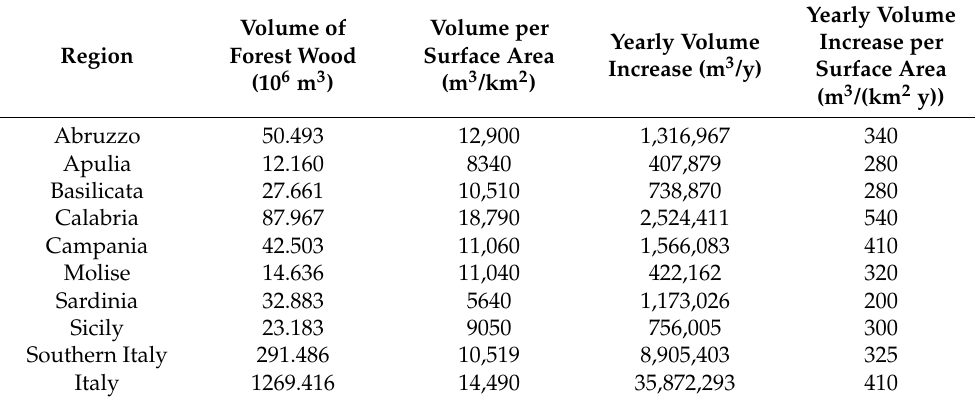
Table 6. Volume and increase of forests in Southern Italy, 2005 data [29]. Partially adapted from INFC 2005–Inventario Nazionale delle Foreste e dei Serbatoi Forestali di Carbonio. Ministero delle Politiche Agricole Alimentari e Forestali, Ispettorato Generale-Corpo Forestale dello Stato. Consiglio per la Ricerca e Sperimentazione in Agricoltura Unit à di ricerca per il Monitoraggio e la Pianificazione Forestale (CRA-MPF) .